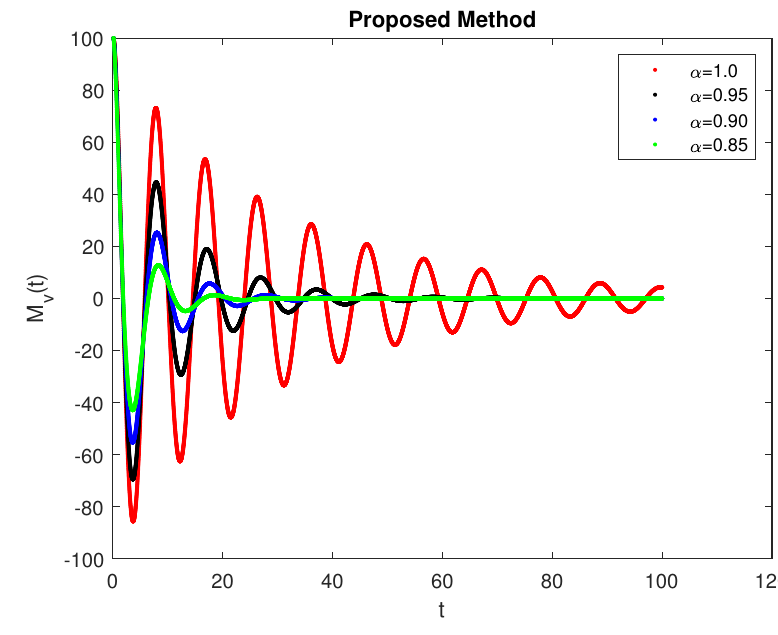
Figure 17: Numerical simulations for τ = 0.9 for Caputo derivative.